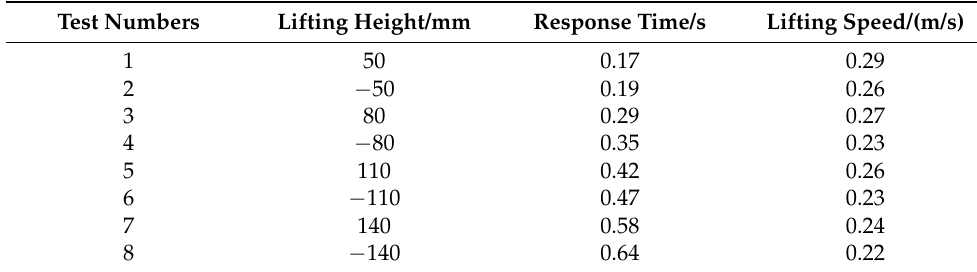
Table 4. Manual control test results of front-suspension mechanism.